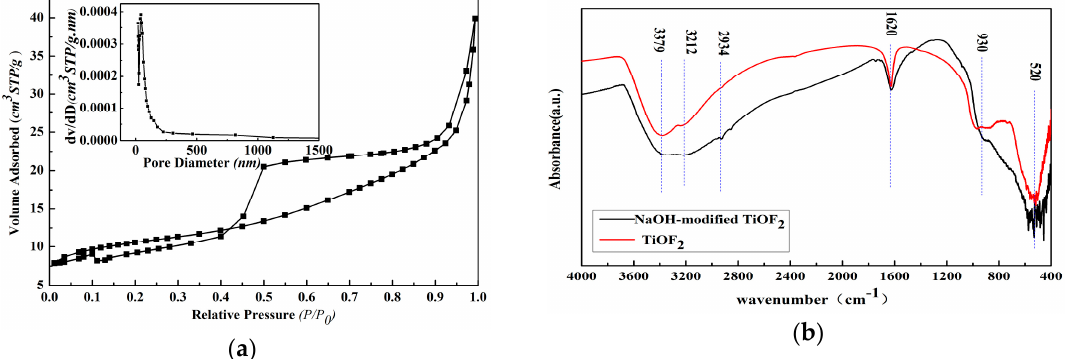
Figure 3. N 2 adsorption-desorption isotherm of the NaOH-modified TiOF 2 ( a ) and the FTIR spectra for TiOF 2 and NaOH-modified TiOF ( b ).